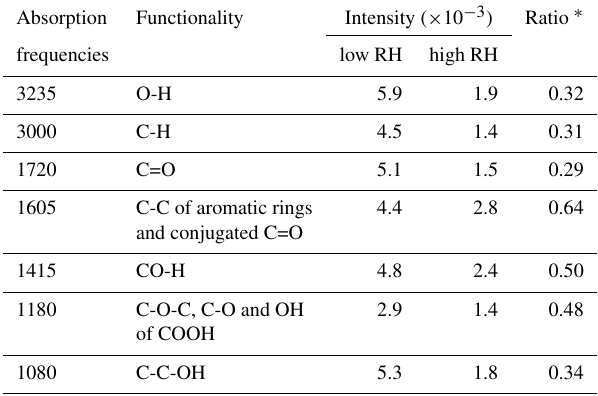
Table 2. Absorbance positions of functional groups and the abun- dance at 14% (Exp. 2) and 74% (Exp. 8)